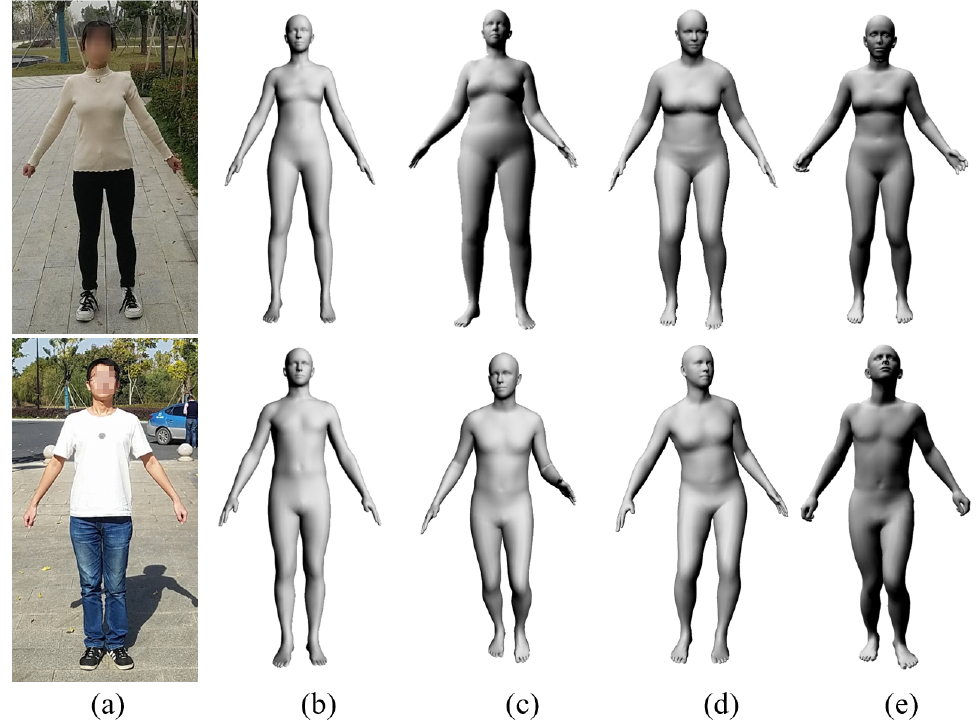
Figure 9. Three-dimensional human model generation and comparison with other methods. From left to right: ( a ) input front-view image, ( b ) 3D model generated by our method, ( c ) HMR [20], ( d ) NBF [23] and ( e ) Smplify-x